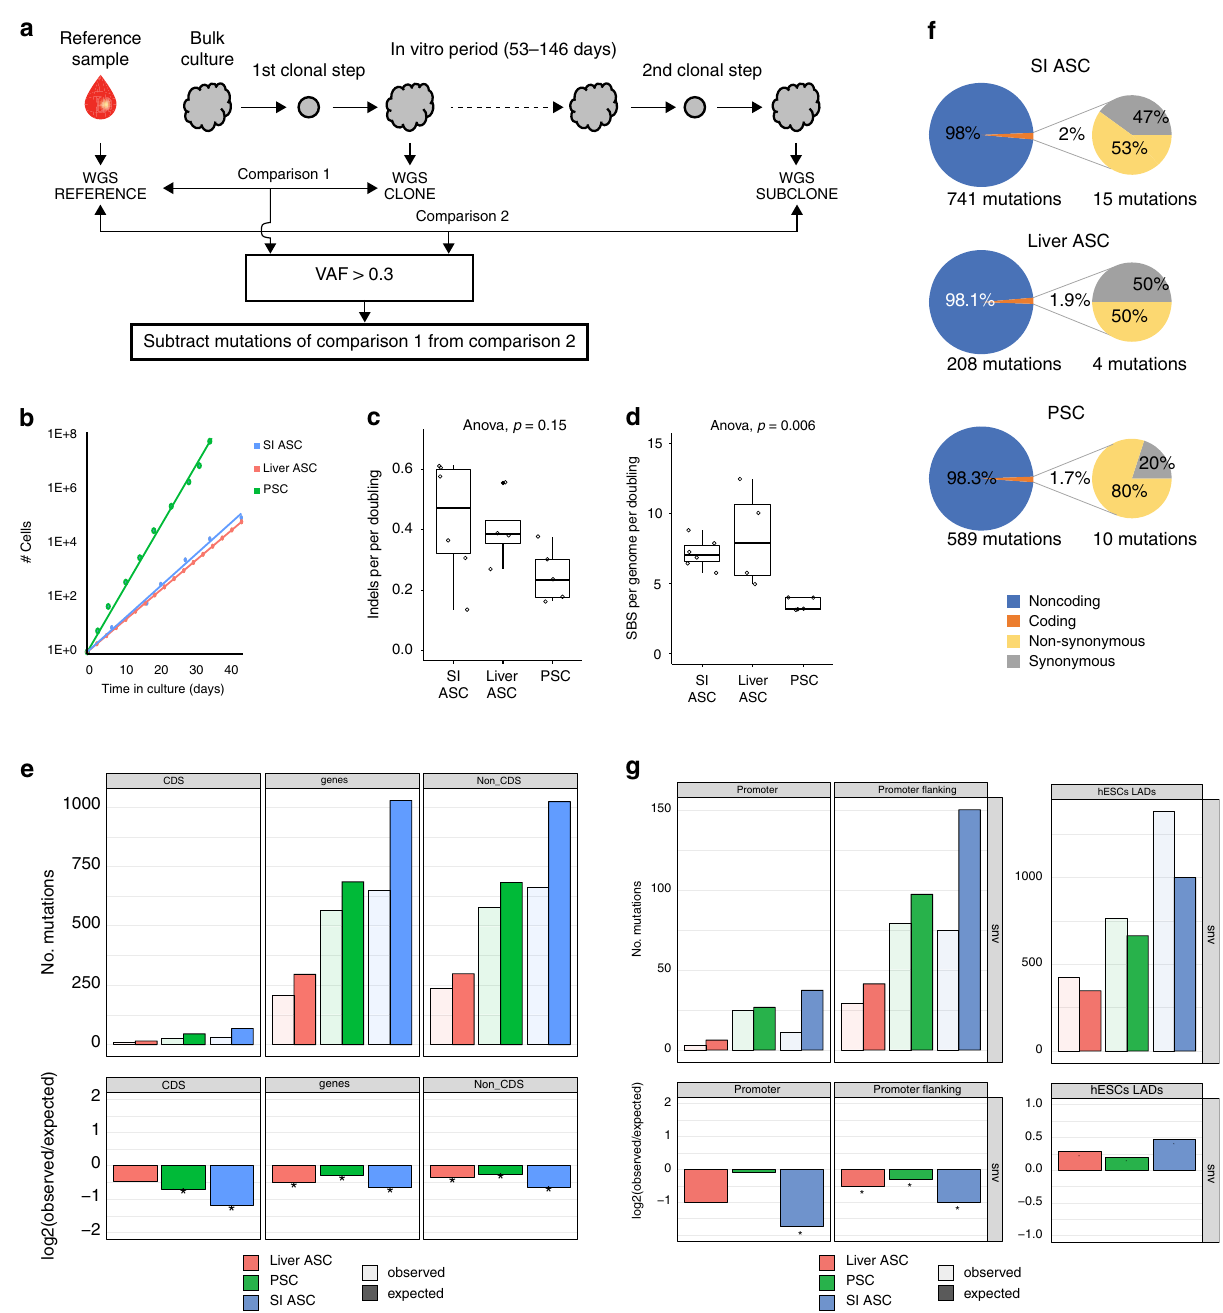
Fig. 1 In vitro mutation accumulation in PSCs ( n = 5), liver stem cells ( n = 4), and intestinal stem cells ( n = 6). a Schematic overview of the experimental setup to determine in vitro-accumulated mutations in individual human PSCs, liver stem cells, and intestinal stem cells. Clonal stem cell lines were cultured for ~2 – 5 months during which mutations were allowed to accumulate. At the end of the culture period, a second clonal step was performed, and the derivative subclones were expanded until enough DNA could be isolated for WGS analysis. A biopsy or bulk culture was used as a reference sample to determine and exclude all germline variants, which were subtracted from the clone (comparison 1) and from the subclone (comparison 2). Finally, with these results, the clonal variants were subtracted to identify all variants that were unique to the subclone. b Growth curves for PSCs (green), liver stem cells (red), and intestinal stem cells (blue). c Box – whisker plots showing the median, fi rst and third quartiles, and minimum and maximum of the number of indels per genome per population doubling (statistical test used: ANOVA). d Box – whisker plots showing the median, fi rst and third quartiles, and minimum and maximum of the number of SBS per genome per population doubling. Statistical test used: ANOVA. e Top panels: genomic distribution of the observed versus the expected amount of mutations per genome per doubling. Bottom panels: log2 of the ratio between the total number of observed mutations versus the total number of the expected amount of mutations. Asterisks denote statistically signi fi cant differences between observed and expected (binomial test). CDS coding sequence. f Relative number of SBS per cell type (left circles) and those affecting protein-coding DNA (right circles). Nonsynonymous SBS leads to amino-acid changes, whereas synonymous mutations do not have an effect on the protein sequence. g Top panels: genomic distribution of the observed versus the expected amount of mutations per genome per doubling at promoter and promoter- fl anking regions. Error bars represent the standard deviation. Bottom panels: log2 of the ratio between the total number of observed versus the total number of the expected amount of mutations at promoter and promoter- fl anking regions. Asterisks denote statistically signi fi cant differences between observed and